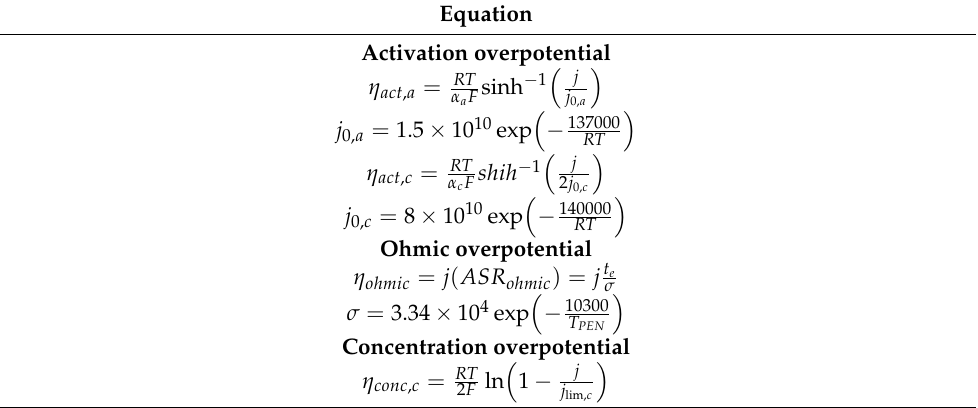
Equation Activation